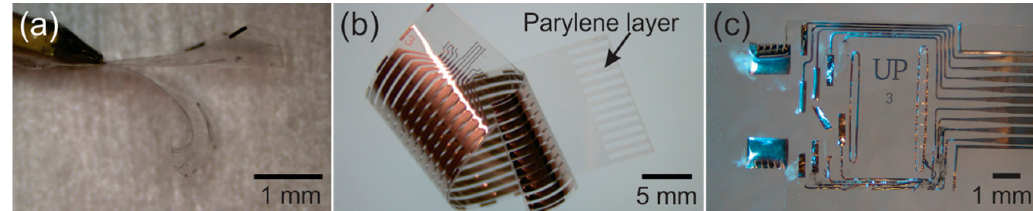
Figure 6. Parylene devices where delamination was noticeable on the macro scale. ( a ) Parylene layers visibly split from each other; ( b ) detachment of the top Parylene layer from the metal and bottom Parylene layers; and ( c ) electrodes and metal traces began to move or slide around between the Parylene layers.